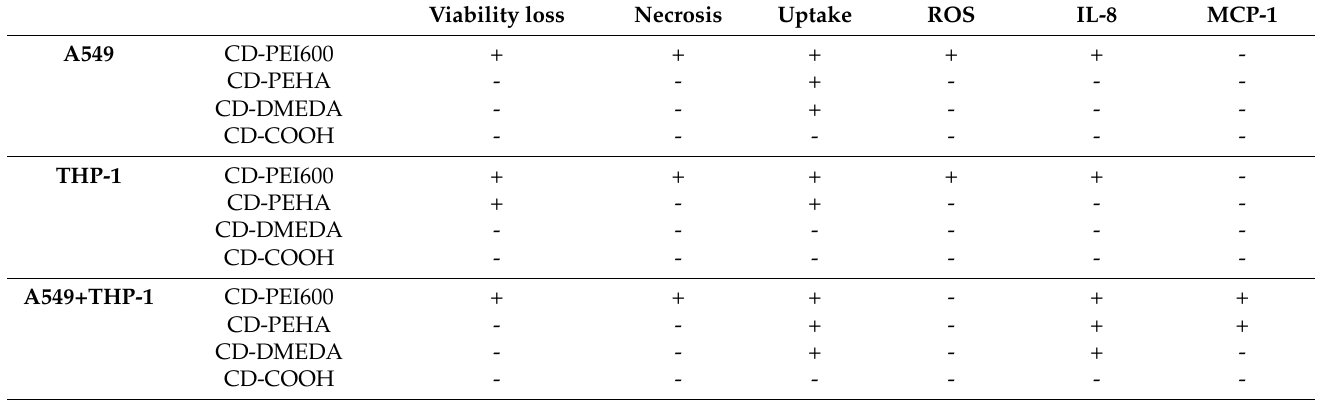
Table 2. Overview of the